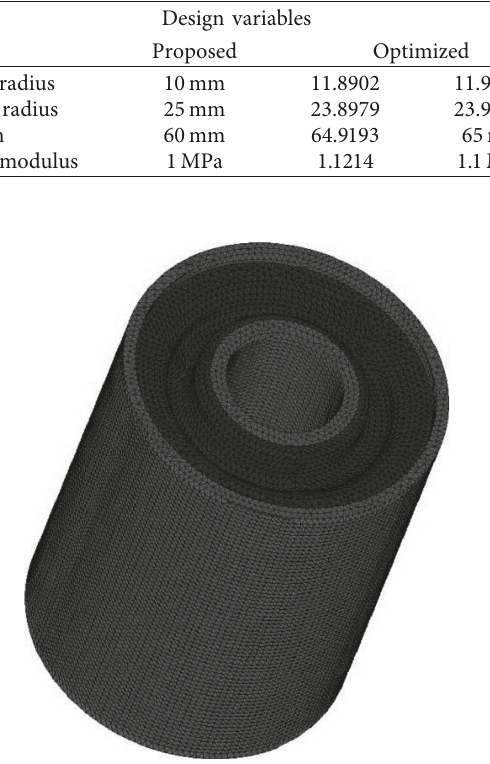
Figure 8: Final mesh for the 3D model of the automotive bushing.